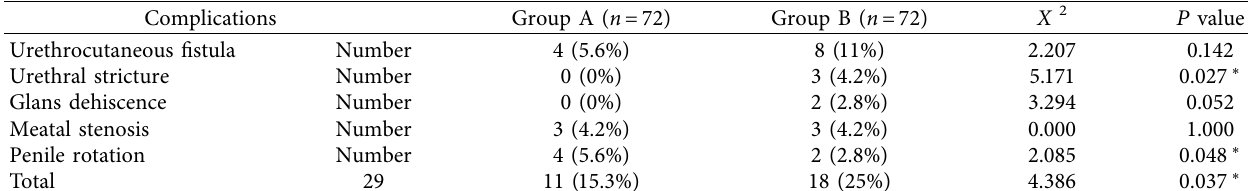
Table 2: Postoperative